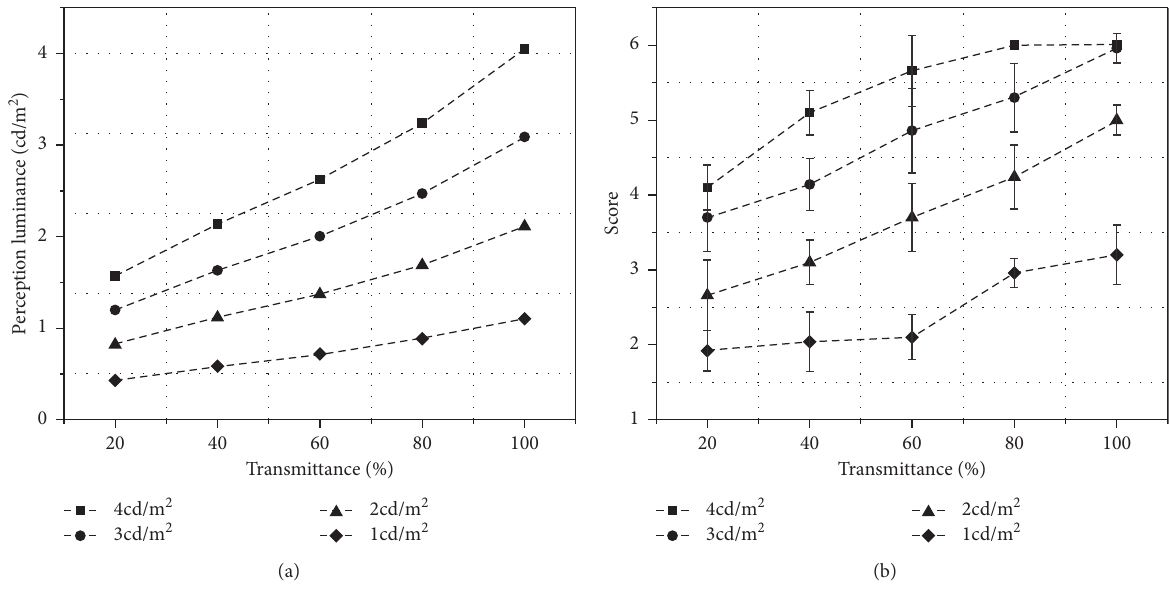
Figure 15: The impact of the luminance and the concentration of fog on perception luminance. (a) The theoretical calculation results of perception luminance under different luminance and fog concentration, CCT � 6500K. (b) The experimental results of the average scores of 50 subjects on visual perception under different luminance and fog concentration, CCT � 6500K. Error bars indicate standard